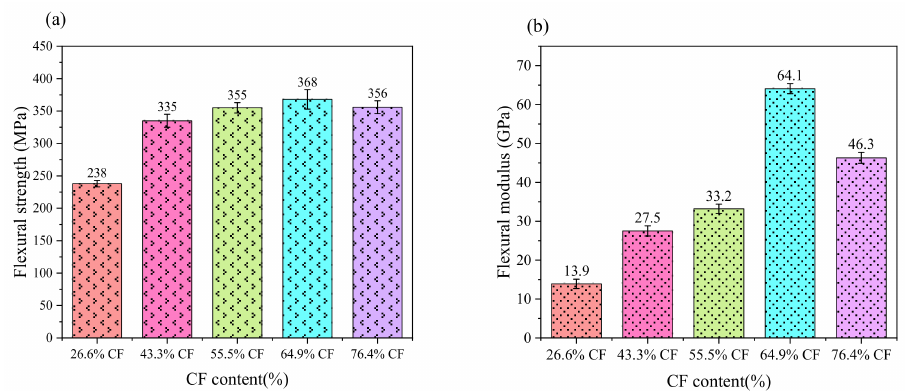
Figure 7. The test results of three-point bending test ( a ) flexural strength, ( b ) flexural